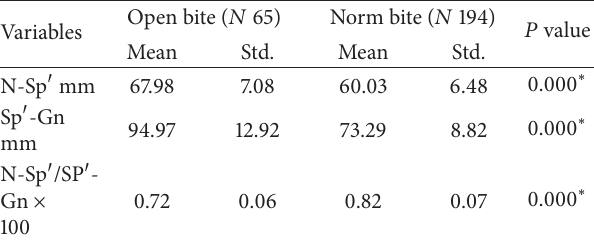
Table 7: The facial height variable for open bite and norm Yemeni adults.